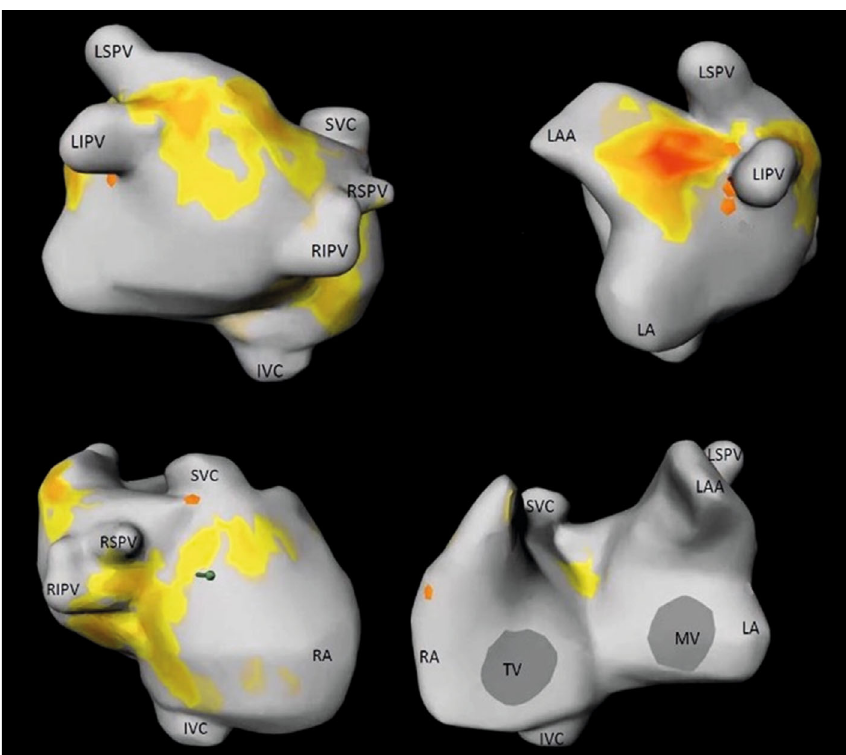
Figure 2: Preoperative noninvasive mapping with CardioInsight ™ -3D Mapping technology. Noninvasive mapping showed rotors and foci originating mainly from the pulmonary veins and left atrium; the right atrium seemed to be free from major sources of AF. IVC: inferior vena cava; LA: left atrium; LAA: left atrial appendix; LIPV: left inferior pulmonary vein; LSPV: left superior pulmonary vein; MV: mitral valve; RA: right atrium; RIPV: right inferior pulmonary vein; RSPV: right superior pulmonary vein; SVC: superior vena cava; TV: tricuspid